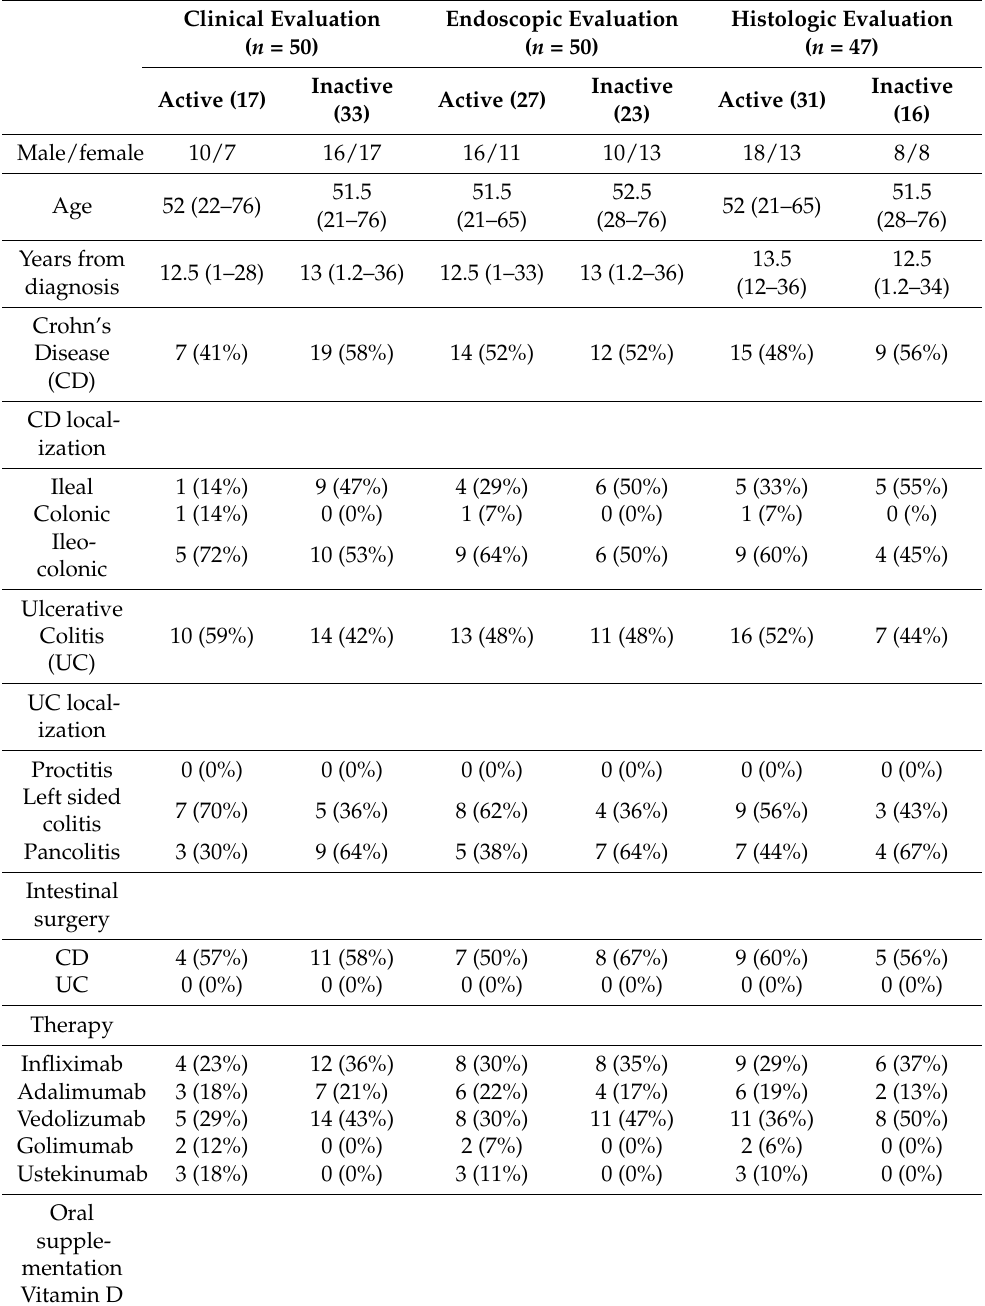
Table 1. Baseline demographic and clinical